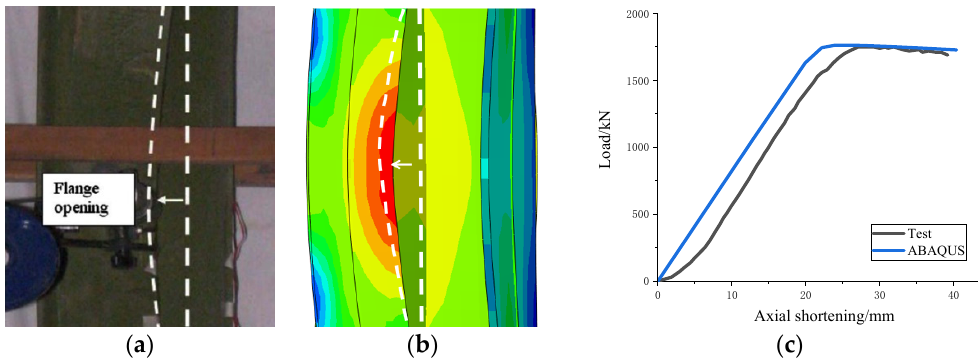
Figure 5. Test and ABAQUS analysis of the specimen CCUB1: ( a ) typical failure mode in the test; ( b ) typical failure mode in ABAQUS; ( c ) load-axial shortening curves.